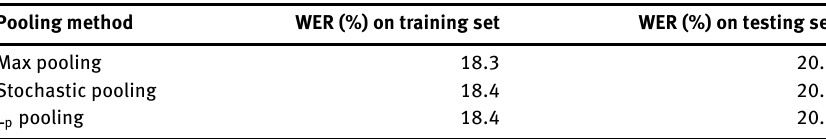
Table 3: WER as a Function of Different Pooling Types.